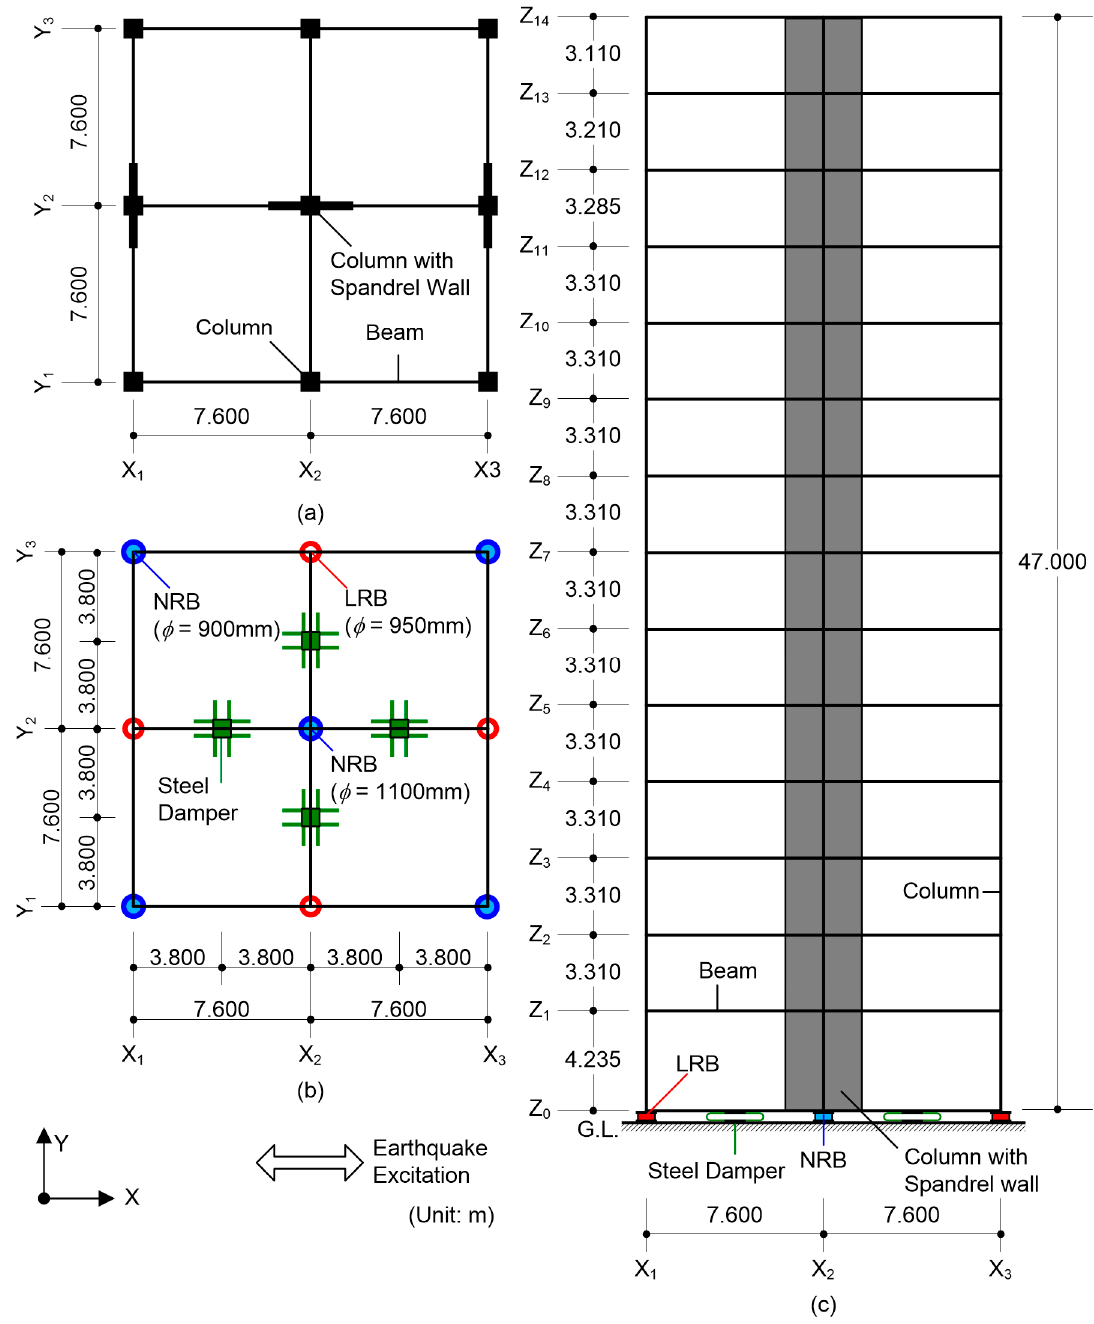
Figure 3. Simplified structural plan and elevation of the base-isolated building considered in this study: ( a ) plan of levels Z 1 to Z 14 ; ( b ) plan of level Z 0 ; ( c ) elevation of frame Y 2 .